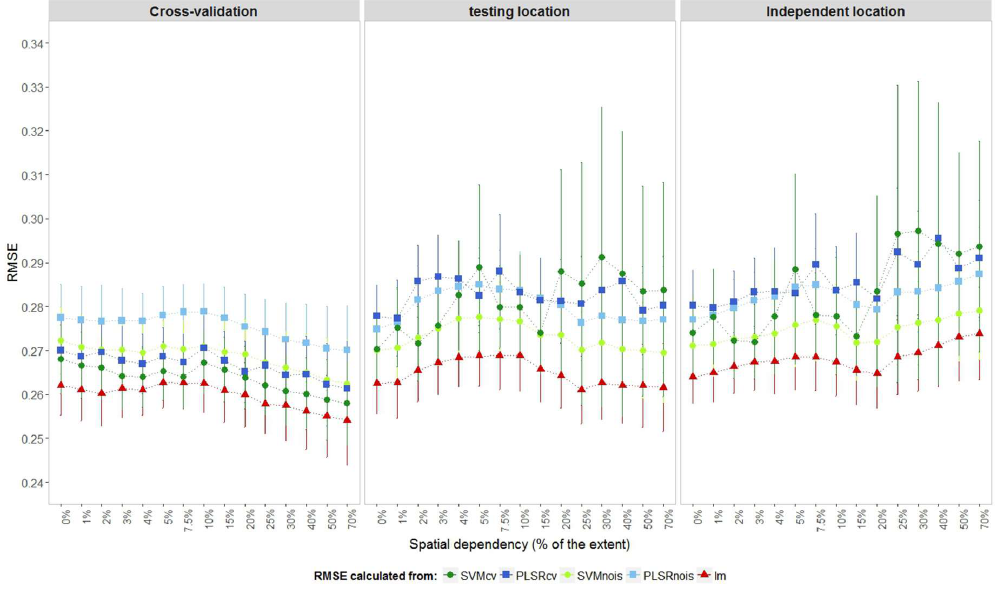
Figure 5. mean and confidence intervals for prediction error by level of spatial dependency estimated from the cross-validation subset (RMSEcv), compared to the testing and independent sets but from different realisation. The different shapes represent different models: squares for PLSR, circles for SVM and triangles for the linear regression model (lm). The darker shades represent the models tuned via traditional cross-validation (PLSRcv and SVMcv), the lighter shades those tuned via the NOIS method (PLSR_NOIS and SVM_NOIS).